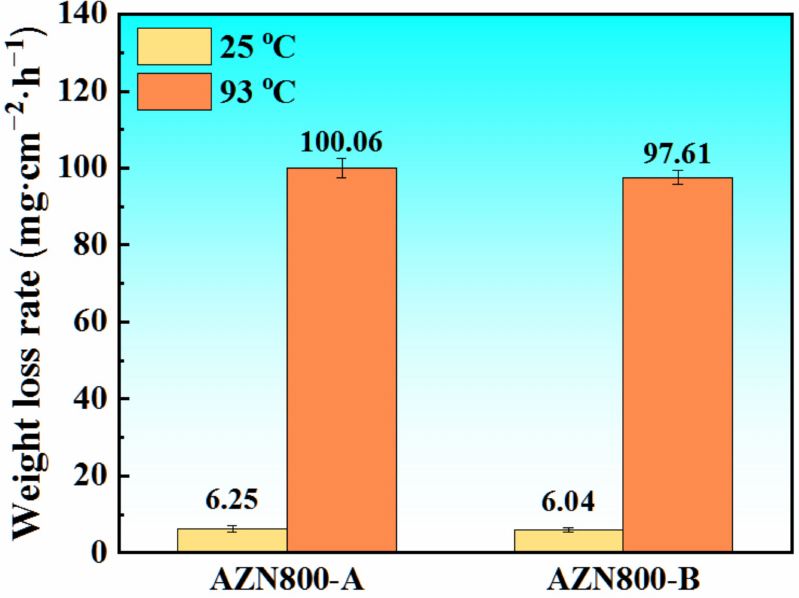
Figure 6. Weight loss rate of the AZN800-A and AZN800-B alloys at different